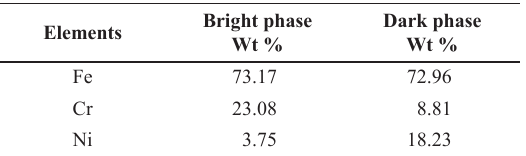
Table 3: Summary of EDS analysis of all the three alloys sintered at 1150